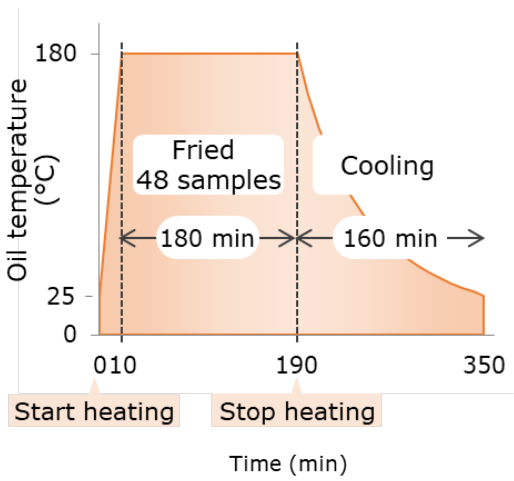
Figure 1. Tempura frying process used in this study.